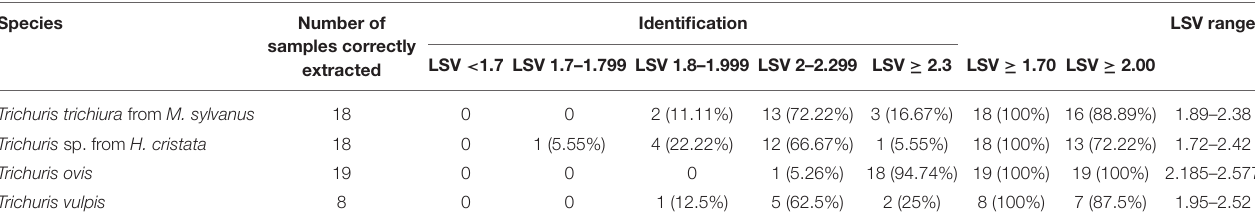
TABLE 2 | Identification of Trichuris species esophagus samples by MALDI-TOF MS, using an internal database.